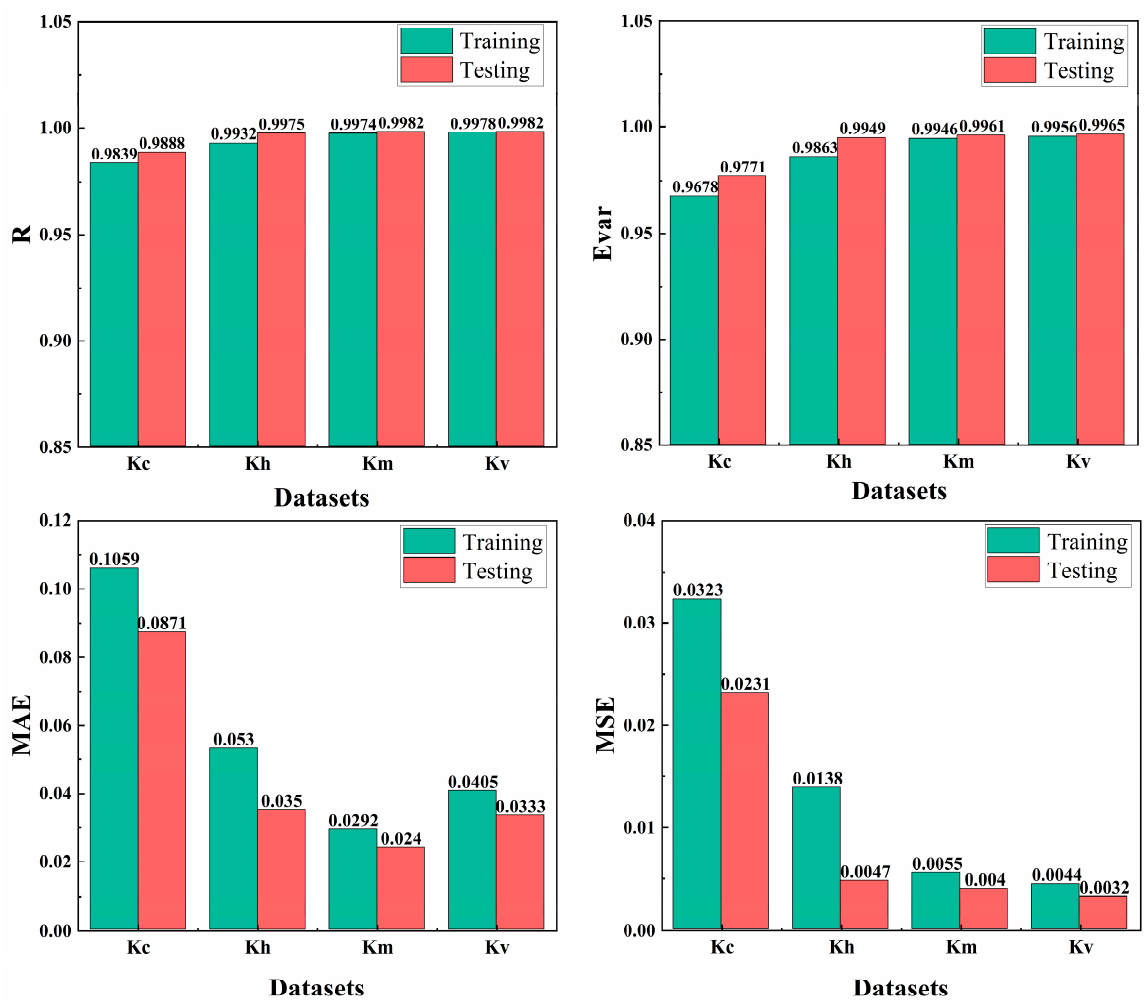
Figure 8. Performance evaluation of the DT-PSO model on four datasets.